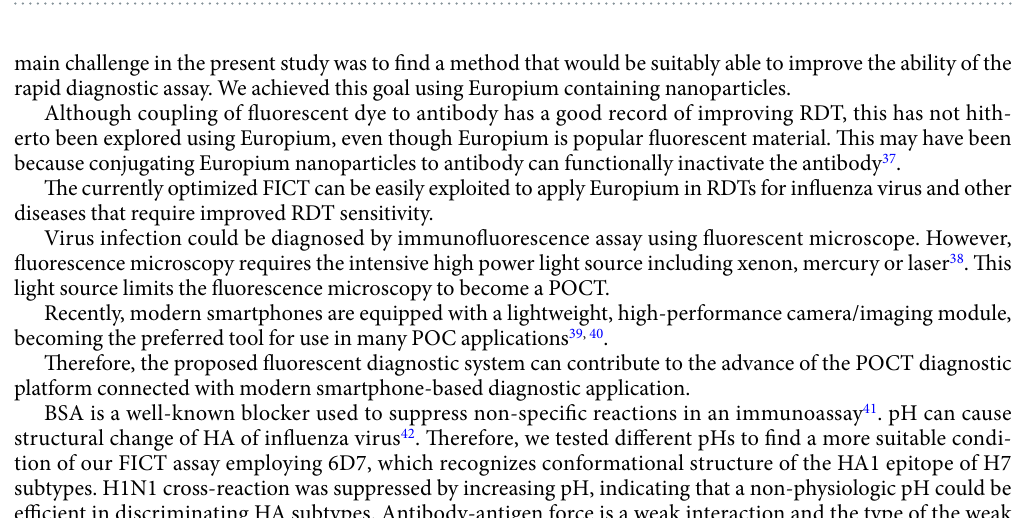
Figure 5. Detection limit of FICT assay for target antigen. FICT employing Europium-conjugated antibodies were tested for the limit of detection (LOD) against H7N9 rHA1 ( A ). The data ( n = 3) are shown as mean ± SD. Linear regression is shown with the dotted line. The arrow indicates the antigen concentration of LOD. Raw fluorescence peaks from the test line (TL) and control line (CL) in FICT are shown in the bottom